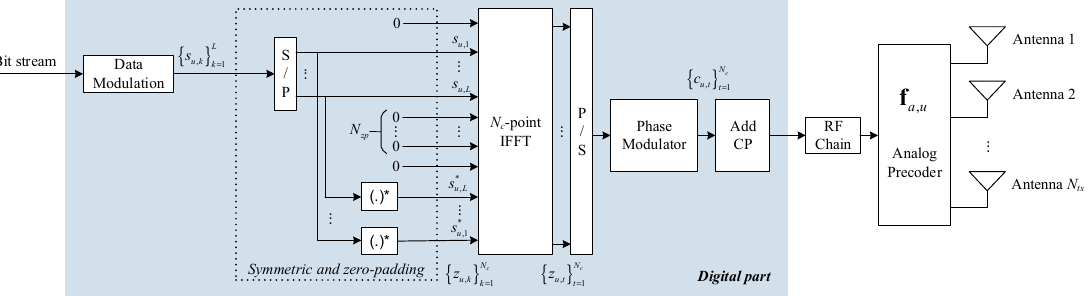
Figure 1. Block diagram of the u th user terminal. IFFT: inverse fast Fourier transform; CP: cyclic prefix; RF: radio frequency.